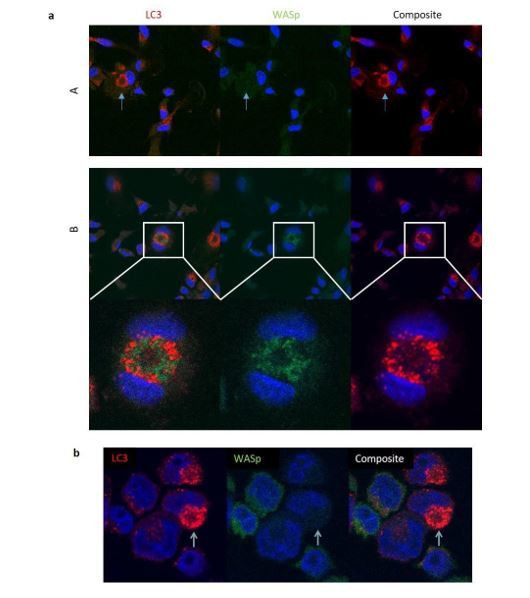
a) Healthy donor MDMs cultured with rapamycin and bafilomycin for 6 hours.Fixed and stained for LC3 (red), WASp (green) and DAPI (blue). Analysed by confocal microscopy at 63x. Panel A displays an example of LC3 punctae without WASp localisation. Panel B displays an example where LC3 appears to be localising with WASp. b) eGFP-WASp THP-1 cells cultured with rapamycin and bafilomycin for 6 hours. Fixed and stained for LC3 (red), nuclei (DAPI). Analysed by confocal microscopy at 63x.